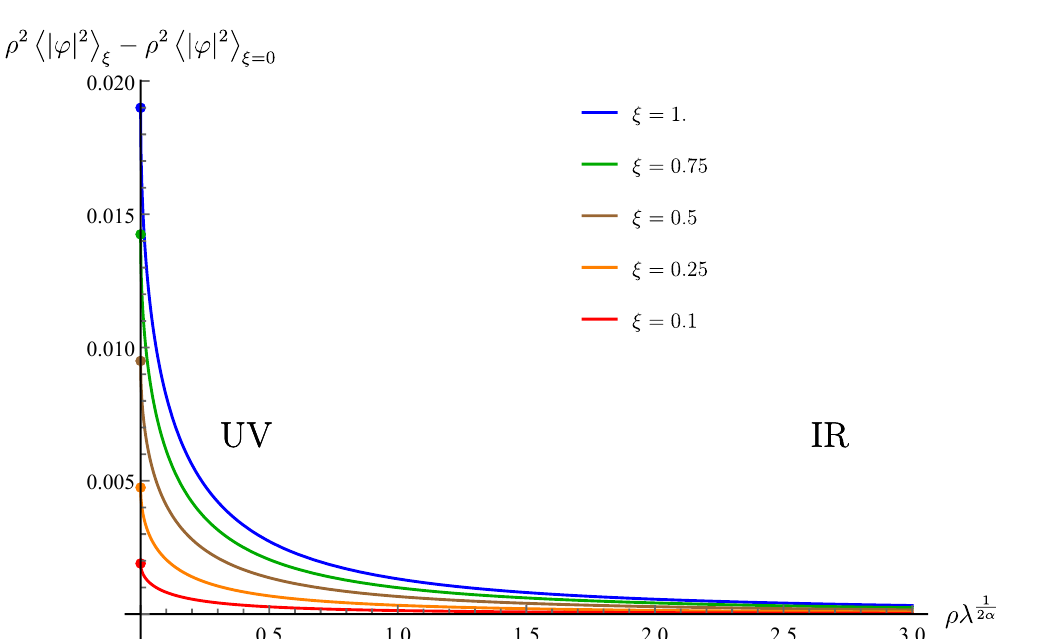
(cid:10) (cid:11) (cid:10) (cid:11) | ϕ | 2 − ρ 2 | ϕ | 2 as a function of the dimensionless quantity ρλ 1 2 α ξ ξ =0